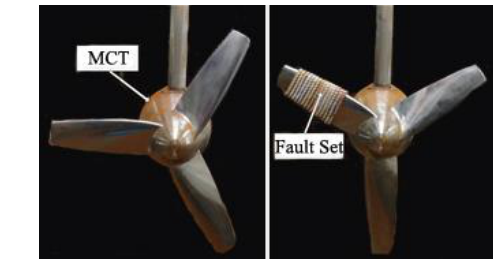
Figure 9. MCT experimental system.